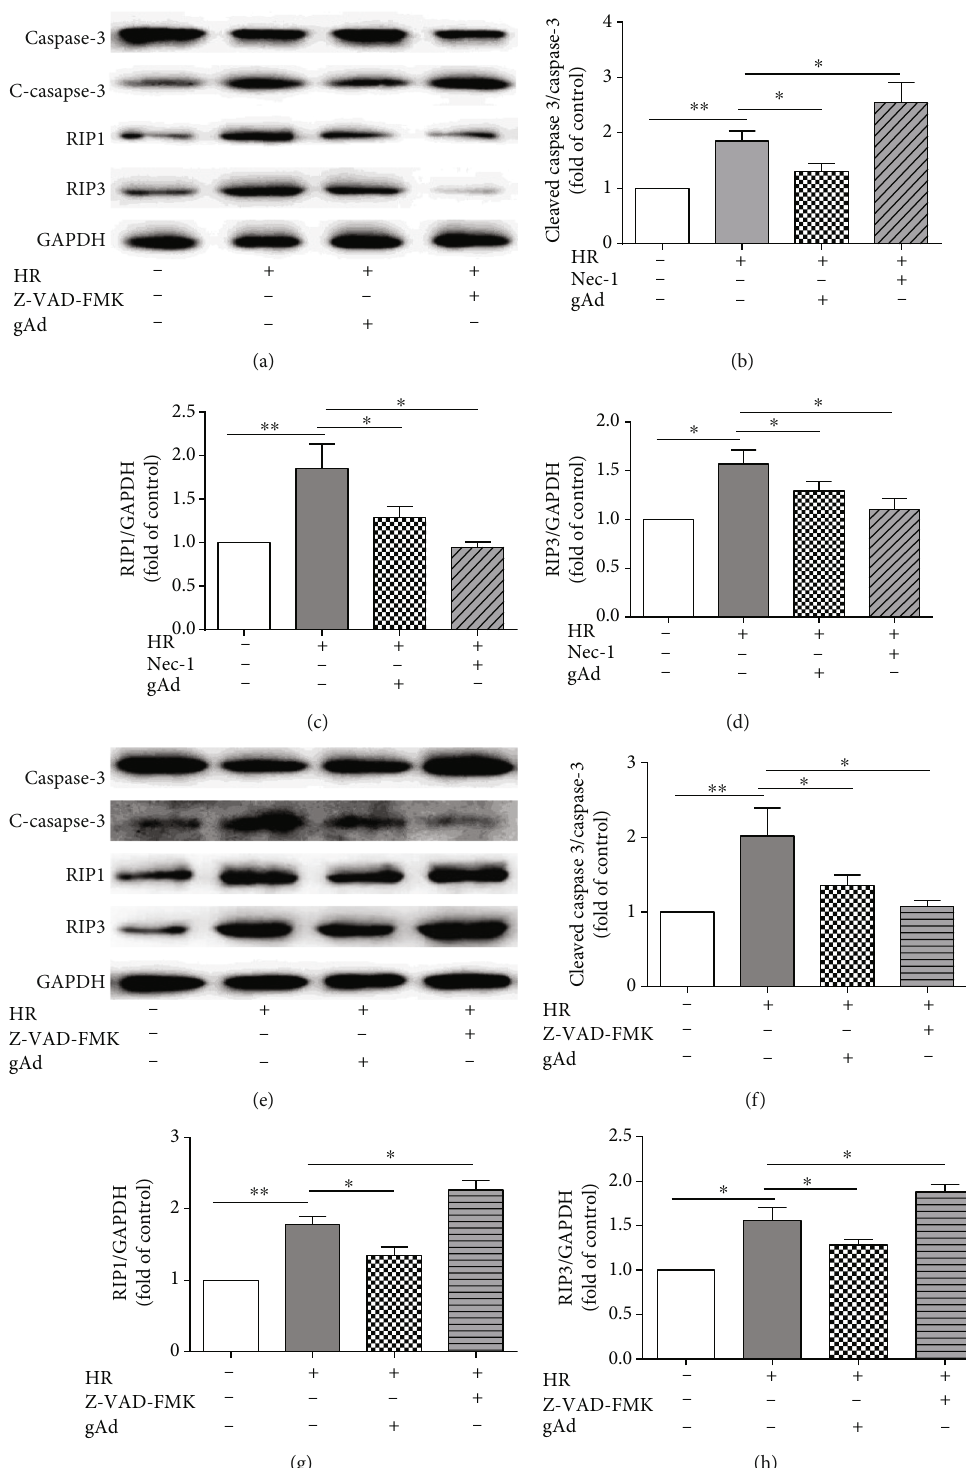
Figure 4: The inhibition e ffi ciency of gAd in hypoxia/reoxygenation-induced apoptosis and necroptosis compared with nec-1 and Z-VAD- FMK. (a, c, d) Western blotting shows that necrostatin-1 (nec-1, 100mM), a speci fi c blocker of necroptosis, inhibited the level of RIP1 and RIP3 and increased the level of cleaved caspase-3 ( n = 4 ). (b) The expression of cleaved caspase-3 was increased in the nec-1 group after H/R ( n = 4 ). (e, f) Z-VAD-FMK (50 mM), a cell-permeable pan-caspase inhibitor, suppresses the cleaved caspase-3 and increased the RIP1 and RIP3 expression ( n = 4 ). (g, h) The expressions of RIP1 and RIP3were increased in the Z-VAD-FMK group after H/R ( n = 4 ). ∗ P < 0 : 05 ; ∗∗ P < 0 : 01